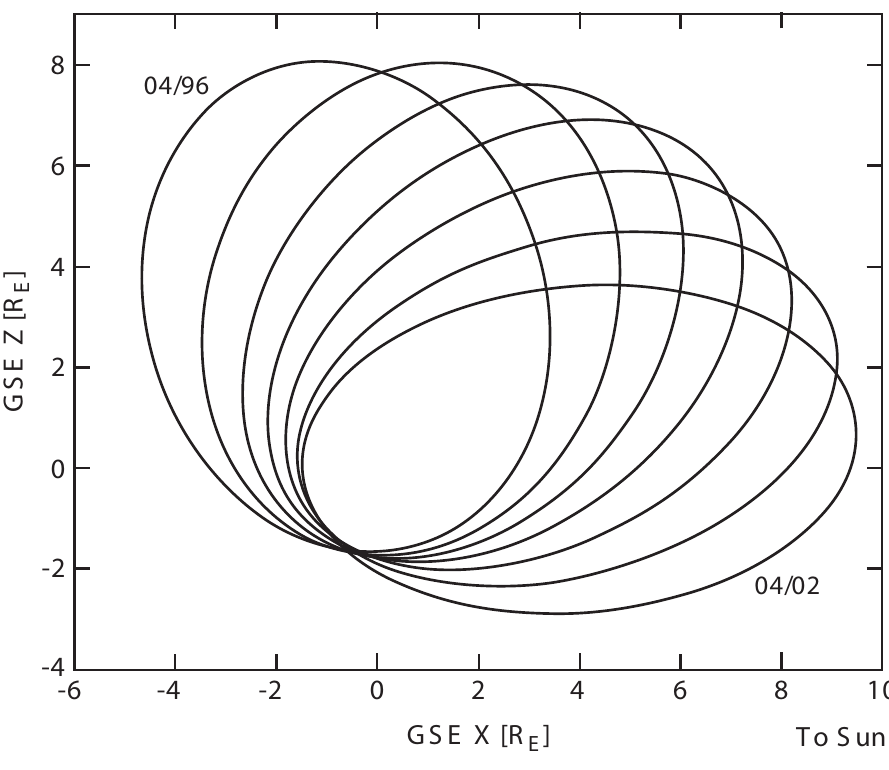
Fig. 1. The evaluation of the Polar orbit from April 1996 to April 2002. The orbit is shown in the solar ecliptic (GSE) X − Z plane for the orbit that was closest in this plane close to the spring equinox. The tilt of the dipole axis relative to the rotational axis of the Earth and the tilt of the rotation axis to the ecliptic pole will cause the coverage to spread over a greater area in any magnetically-oriented coordinate system, such as the solar magnetic (SM) system used in this